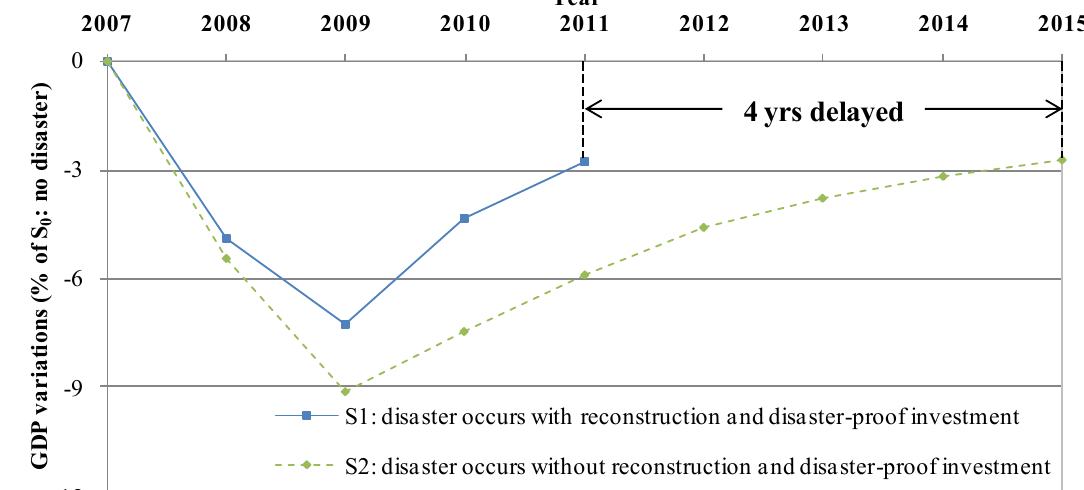
Fig. 4. Comparision of post-disaster economic recovery between S